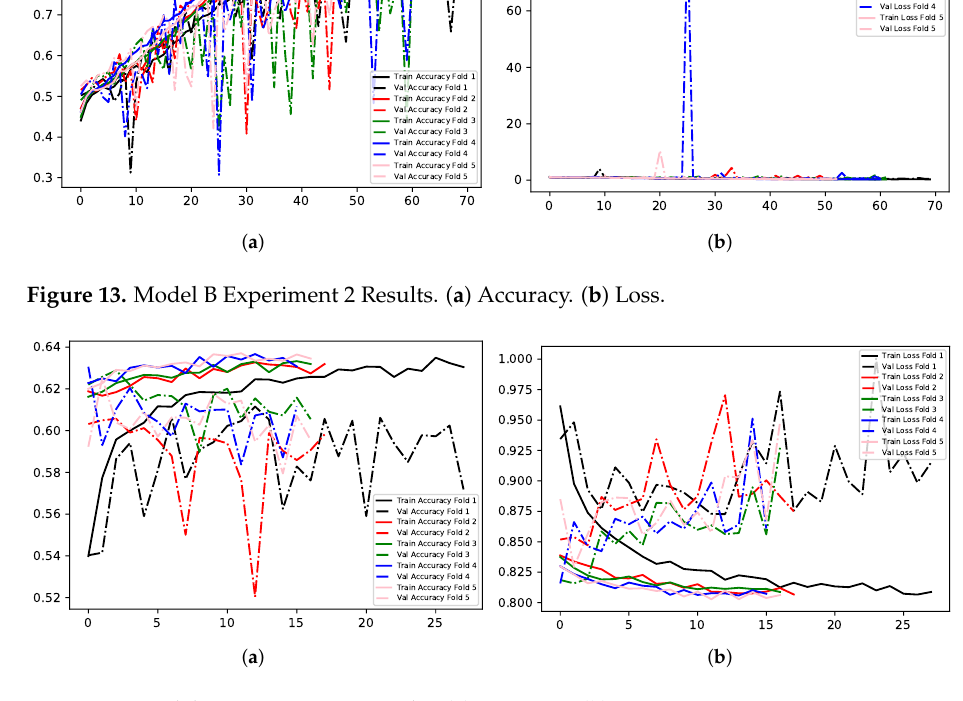
Figure 14. Model B Experiment 3 Results. ( a ) Accuracy. ( b )